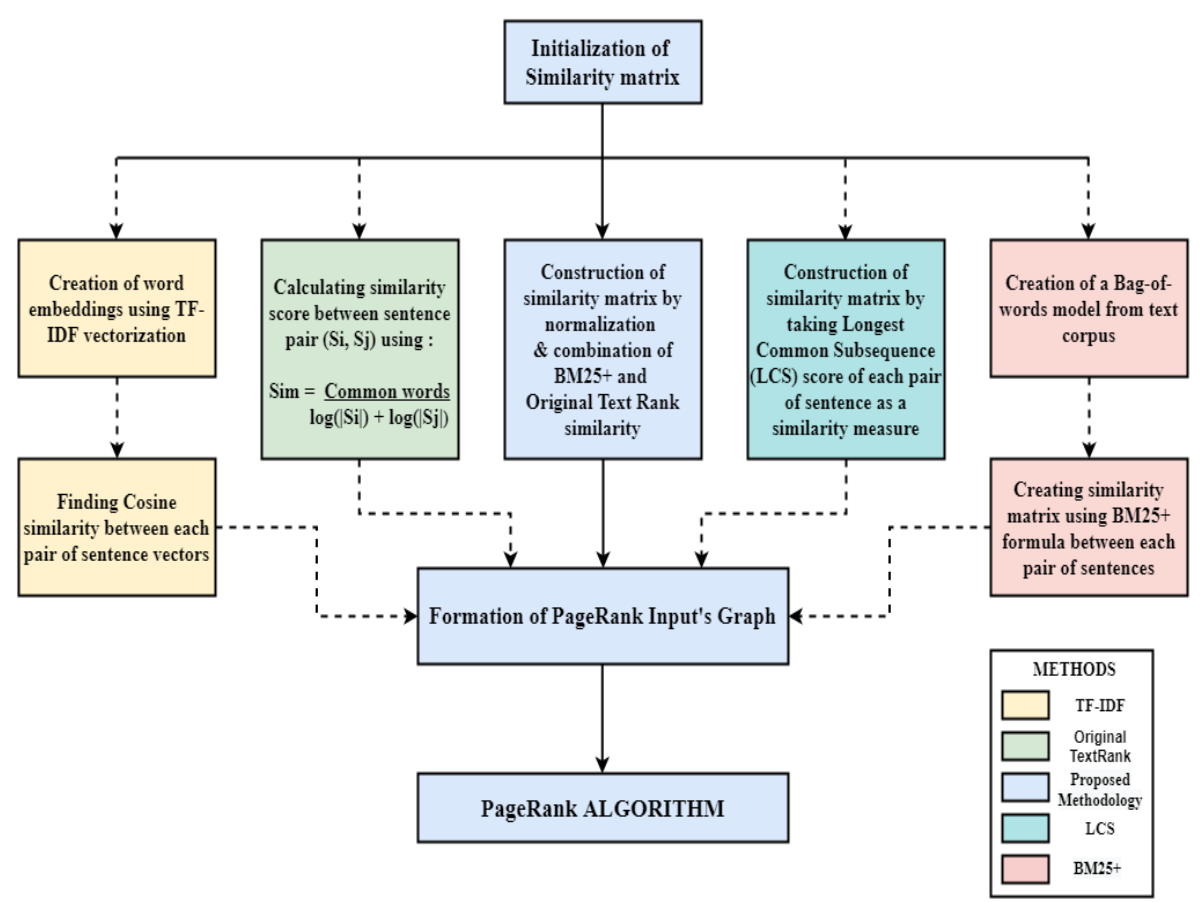
Figure 3. Variations in similarity function of TextRank algorithm.